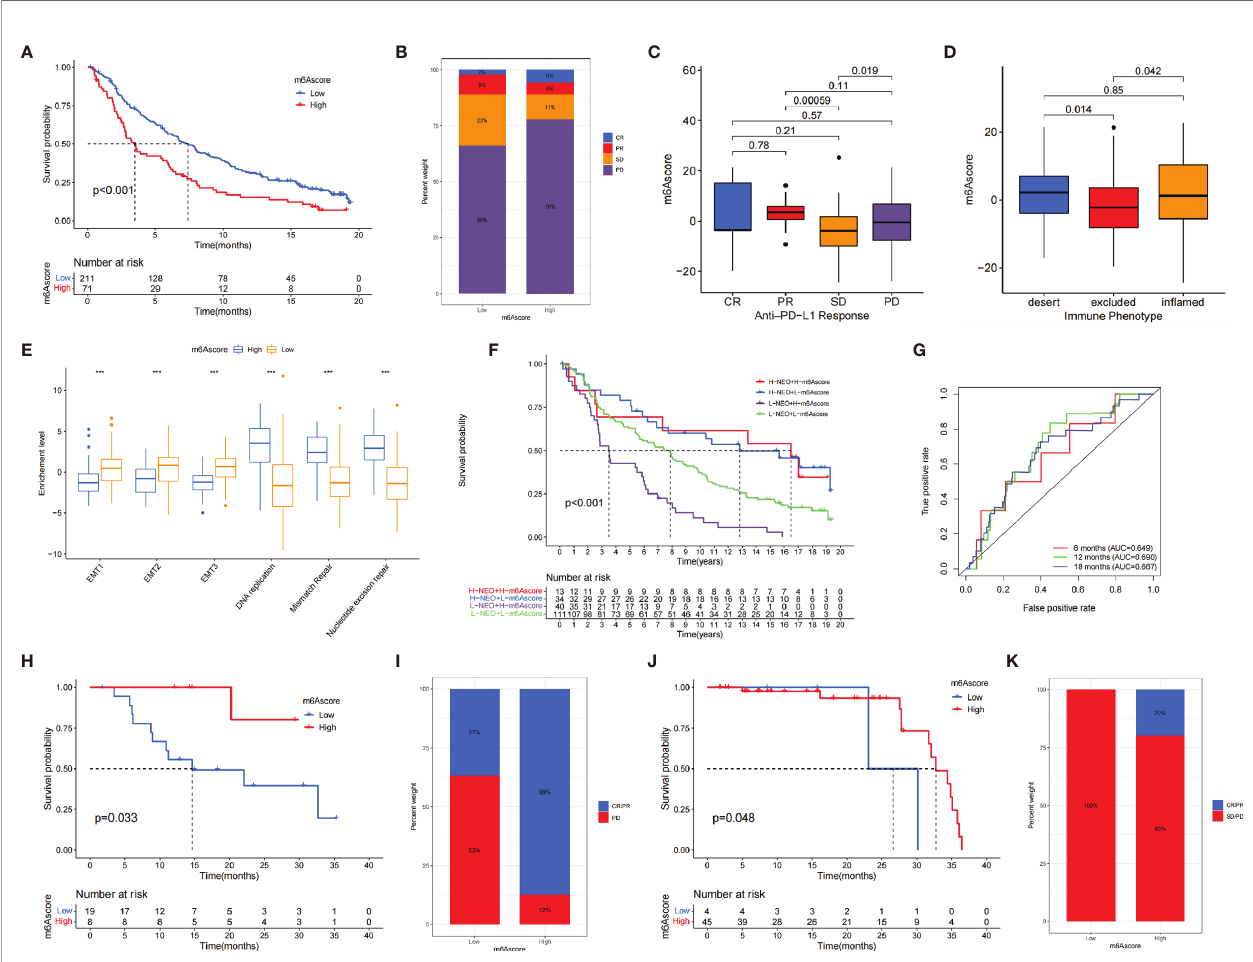
FIGURE 6 | The role of m 6 A score in anti-PD-1/L1 cohorts. (A) The survival analysis of patients in low and high m 6 A score subgroups in the IMvigor210 cohort ( p < 0.001). (B) The proportion of patients with different response to immunotherapy in IMvigor210 cohort. SD, stable disease; PD, progressive disease; CR, complete response; PR, partial response. (C) Distribution of m 6 A score in different response groups. (D) The tumor immune phenotypes were validated in IMvigor210 cohort. (E) Differences in EMT pathways and DNA repair-related pathways between low and high m 6 A score groups (* p < 0.05; ** p < 0.01; *** p < 0.001). (F) The survival analysis of patients who received immunotherapy strati fi ed by both m 6 A score and neoantigen burden. H, high; L, low; NEO, neoantigen burden ( p < 0.001). (G) The AUC of the quanti fi cation of m 6 A score in patients treated with immunotherapy (6 months, AUC = 0.649; 12 months, AUC = 0.690; 18 months, AUC = 0.667). (H) The survival analysis of patients in low – and high – m 6 A score subgroups in the GSE78220 cohort ( p = 0.033). (I) The proportion of patients with different responses to immunotherapy in GSE78220 cohort. (J) The survival analysis of patients in low – and high – m 6 A score subgroups in the Riaz et al. cohort ( p = 0.048). (K) The proportion of patients with different immunotherapy response in Riaz et al.